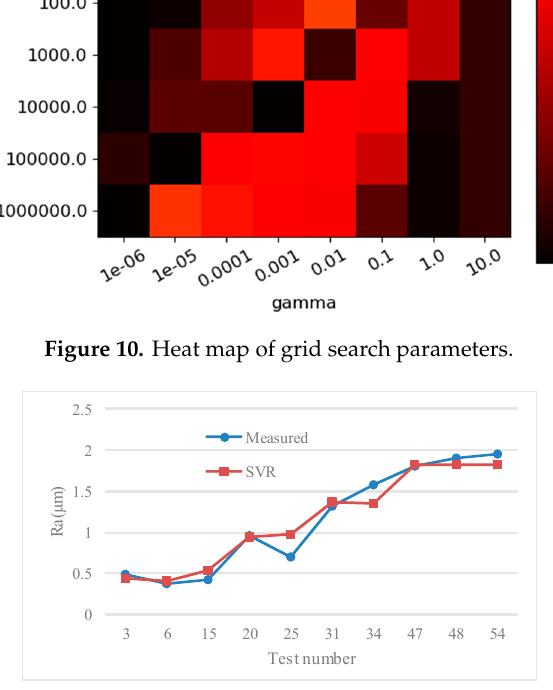
Figure 11. Support vector regression (SVR) prediction results.